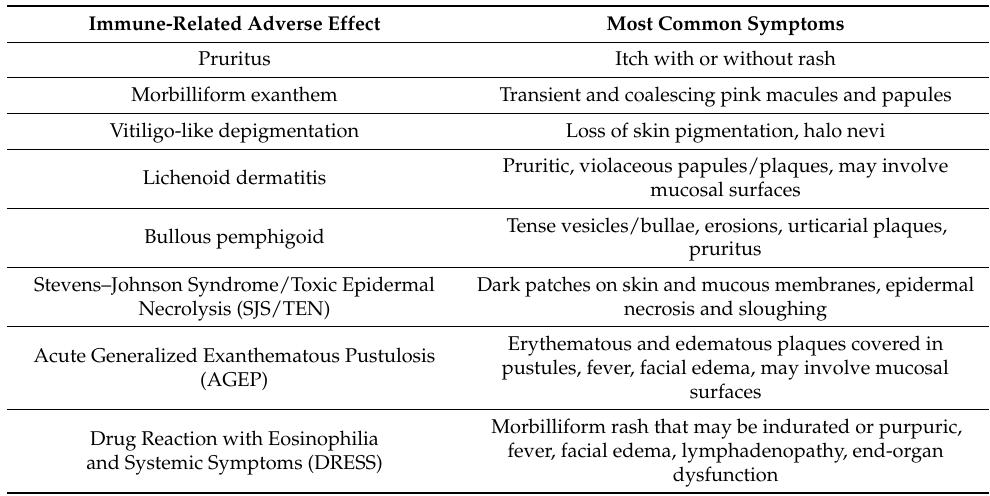
Table 4. ICI-associated dermatotoxicities and their